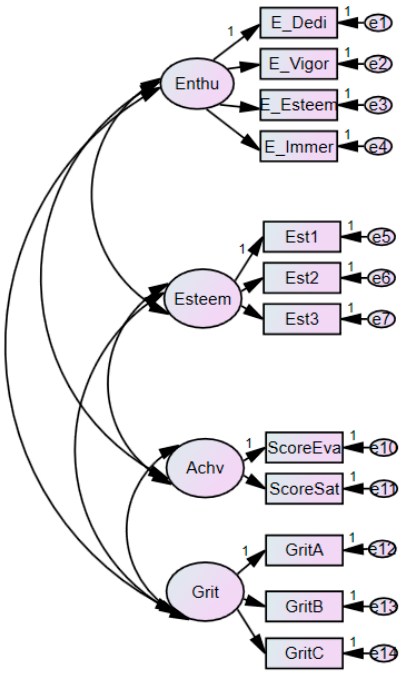
Figure 2. Confirmative factor